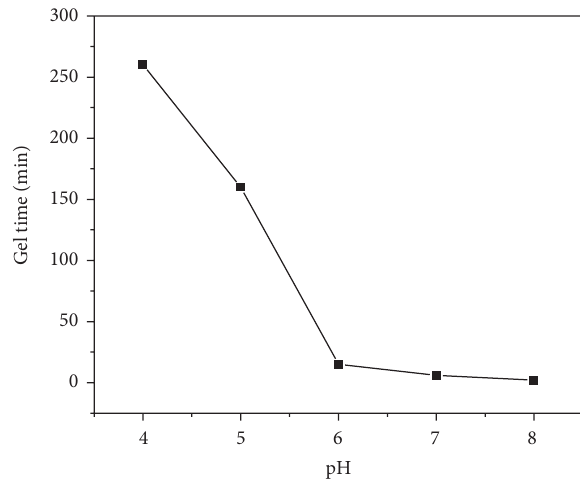
Figure 1: The relation of gelling time to the pH value of the mixture.